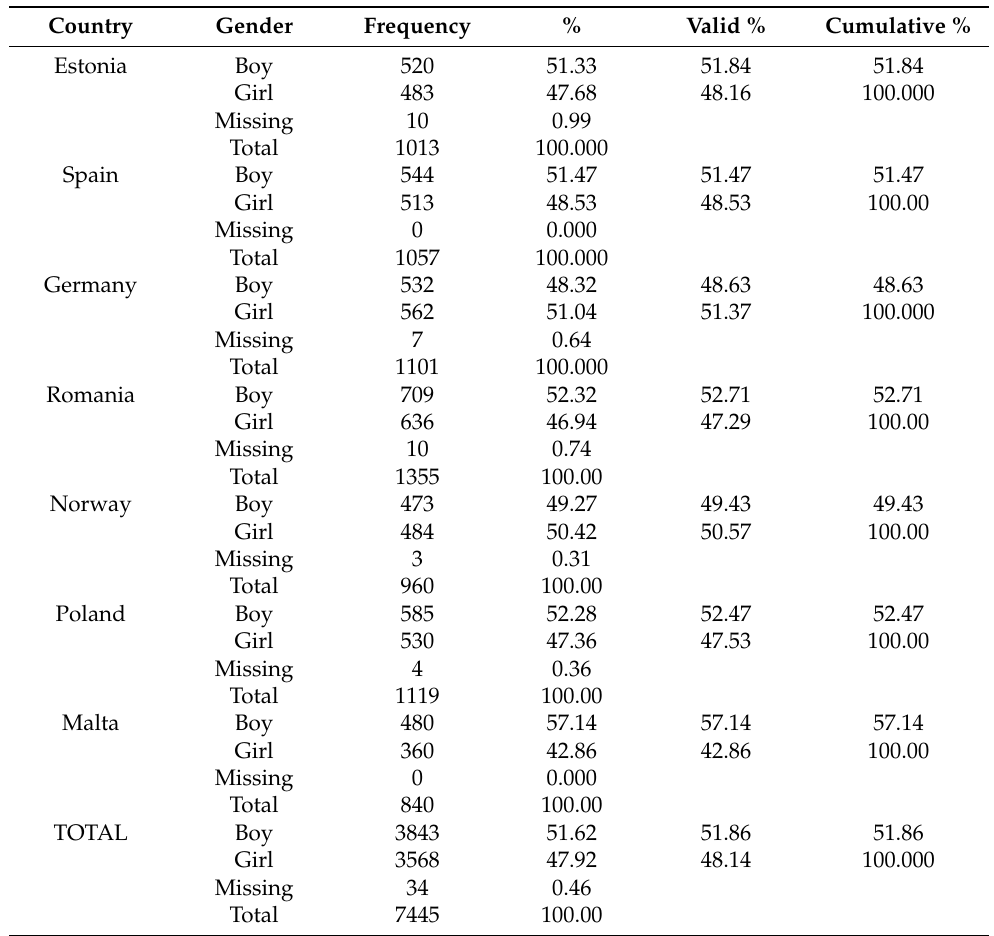
Table 1. Descriptive statistics of the sample by country and